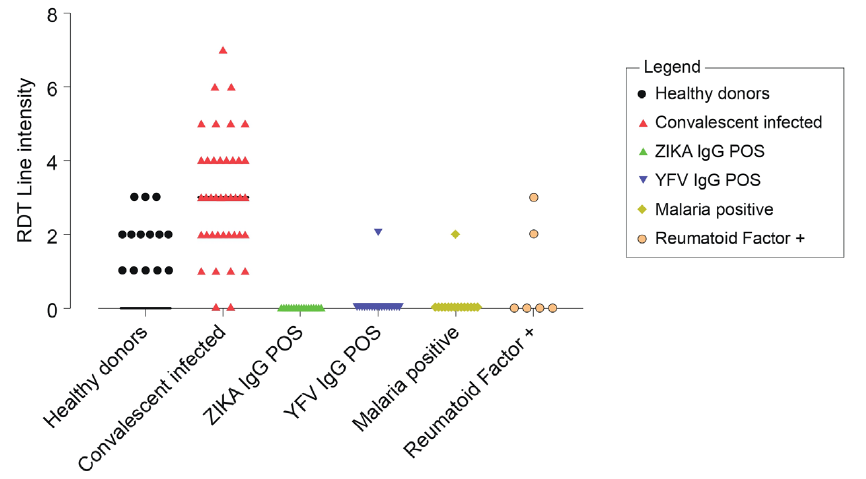
Figure 5. Sensitivity and s pecificity of IgG test